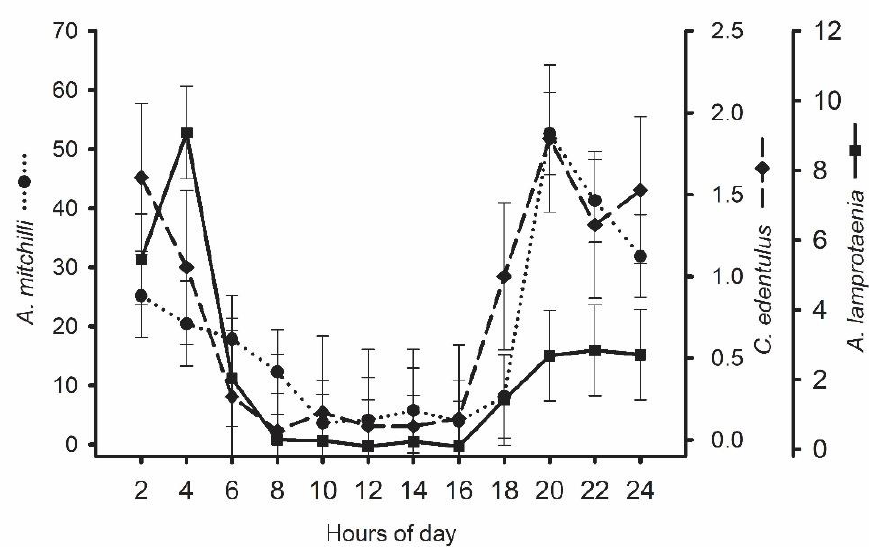
Figure 3. Mean and standard error values by hour of A. mitchilli, A. lamprotaenia and C. edentulus. Table 2. Correlations between environmental variables and species-derived sample scores, signifi- cance and variance inflation factors (VIF) from redundancy analysis (RDA).